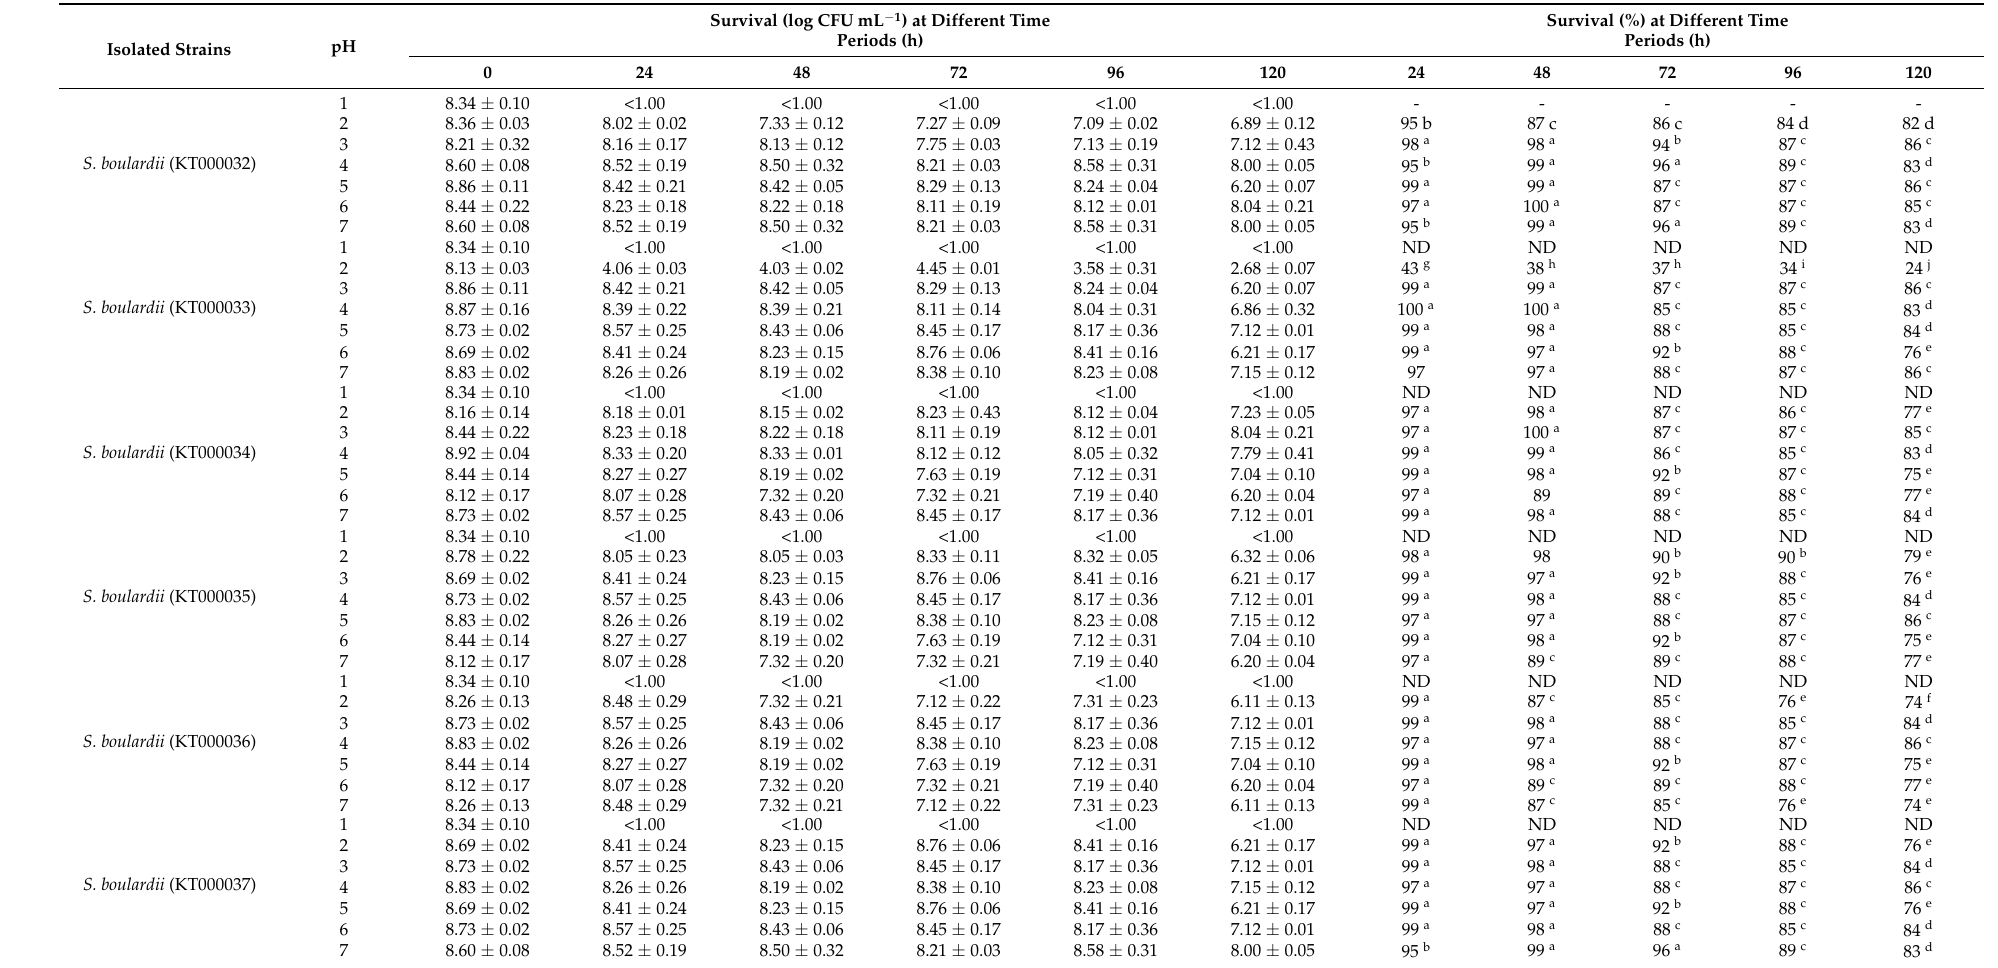
Table 1. Acid tolerance of six Saccharomyces boulardii strains isolated from frozen idli batter in phosphate-saline buffer (pH 2.5).